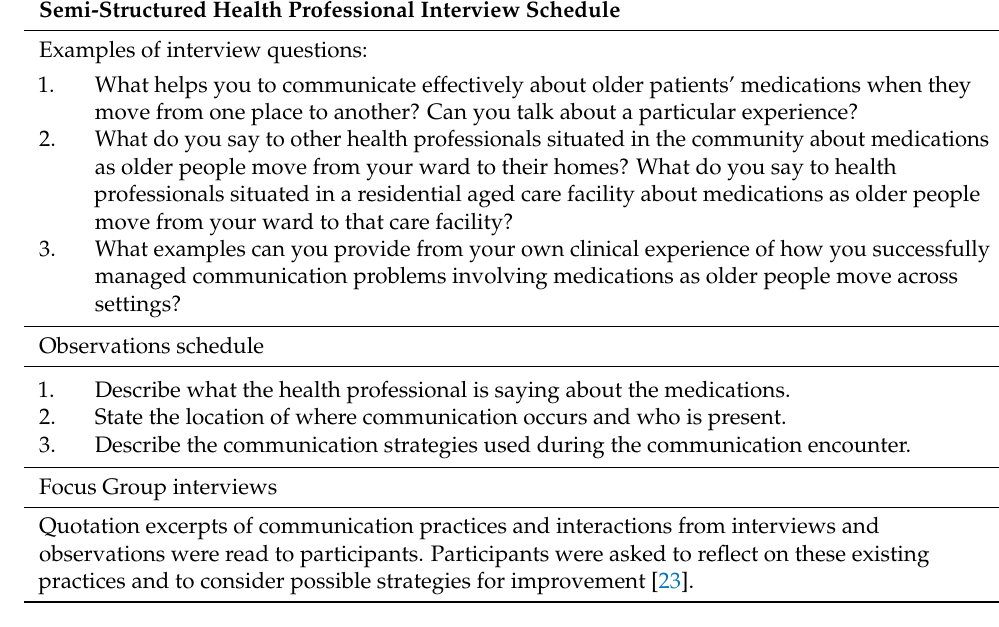
Table 1. Interview, observations and focus group